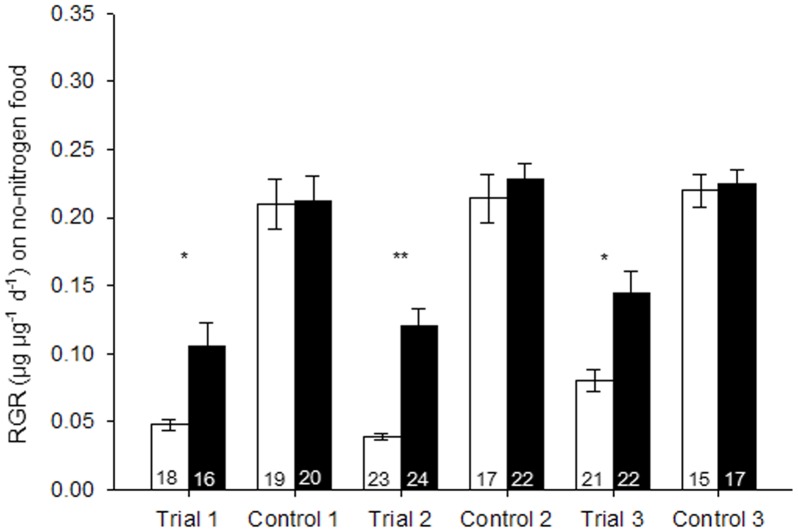
Mean relative growth rate (RGR) of B. tabaci females reared on standard diet (control) or no-nitrogen diet.Black bars and white bars indicate infected and noninfected females, respectively. Replicate numbers are noted within the columns. Values are means±SE. The experiment was performed three times (trial 1–3). For each paired comparison (± infection), asterisks indicate a significant difference (*, p<0.05; **, p<0.01) based on a t-test.